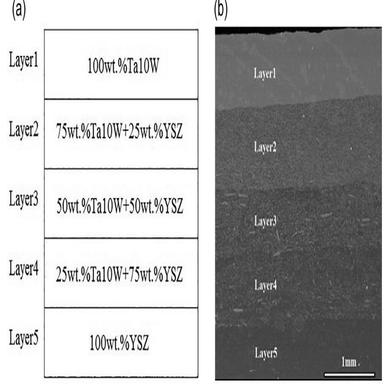
Schematic description of the coatings and substrate. (a)Composition of each layer, (b)SEM of sample's profile.